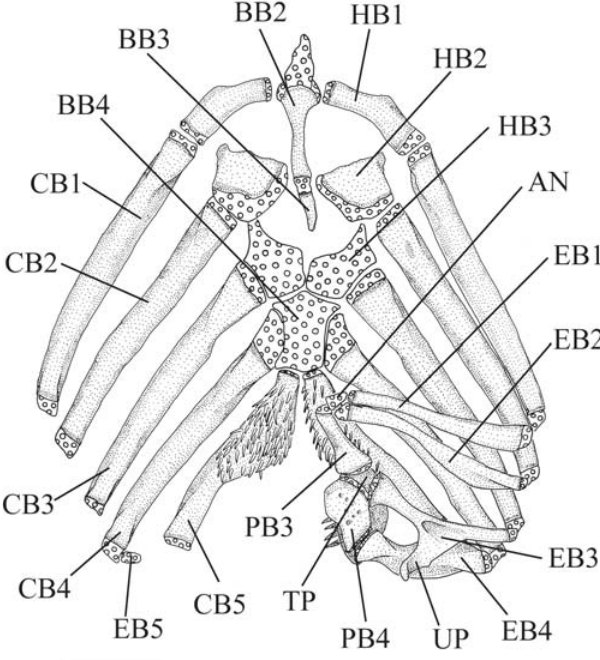
Fig. 6. Gill arches of Rhamdiopsis krugi , LIRP 5928, 33.9 mm SL, paratype. Dorsal view. Gill rakers and dorsal elements of left gill arches not shown. AN ) accessory cartilaginous nodule; BB2-4 ) basibranchials 2 to 4; CB1-5 ) ceratobranchials 1 to 5; EB1-5 ) epibranchials 1 to 5; HB1-3 ) hypobranchials 1 to 3; PB3-4 ) pharyngobranchials 3 and 4; TP ) tooth plate; and UP ) uncinate process. Scale bar = 0.5